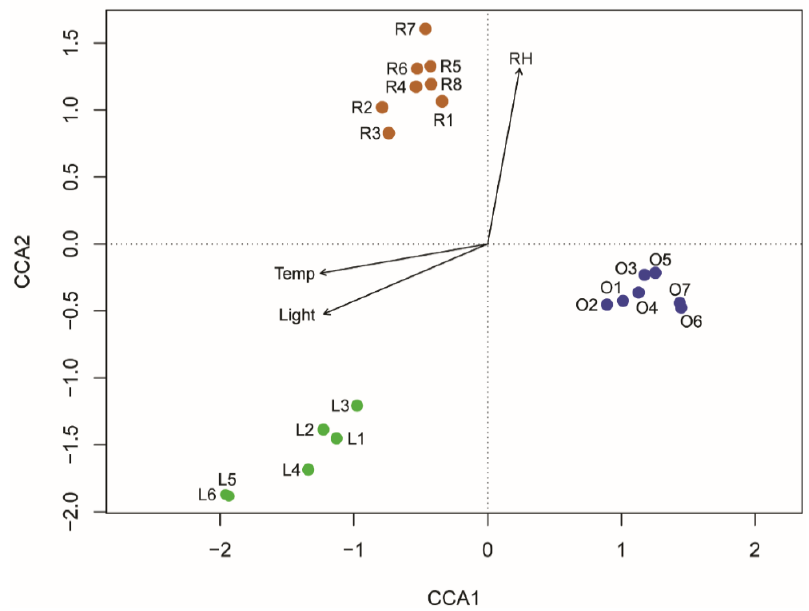
Figure 5. Canonical correspondence analysis (CCA) showing the correlation between biofilm communities and environmental parameters. For colour legend, refer to Figure 4. RH = relative humidity; Temp = Temperature (°C).